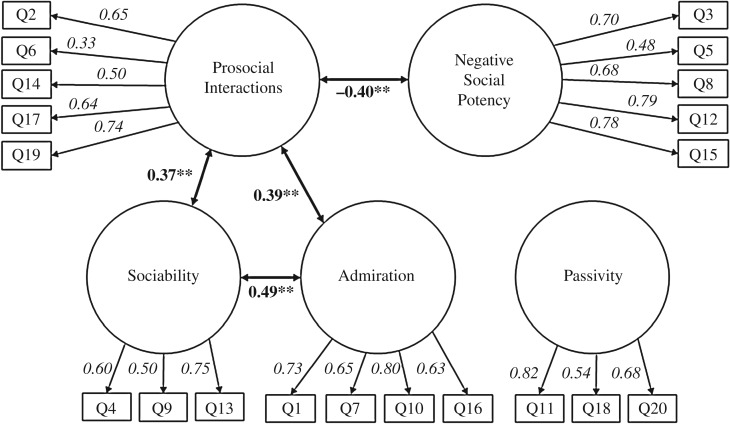
Social Reward Questionnaire—Adolescent Version (SRQ-A). Correlation coefficients are in bold, **p < 0.01, only significant correlations are shown; standardized factor loadings are in italics.